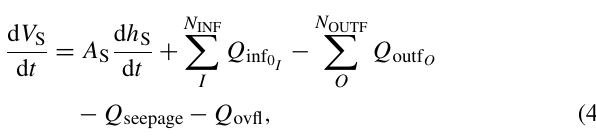
is computed from the local salinity and temperature accord- ing to TEOS-10 (http://teos-10.org, last access: 16